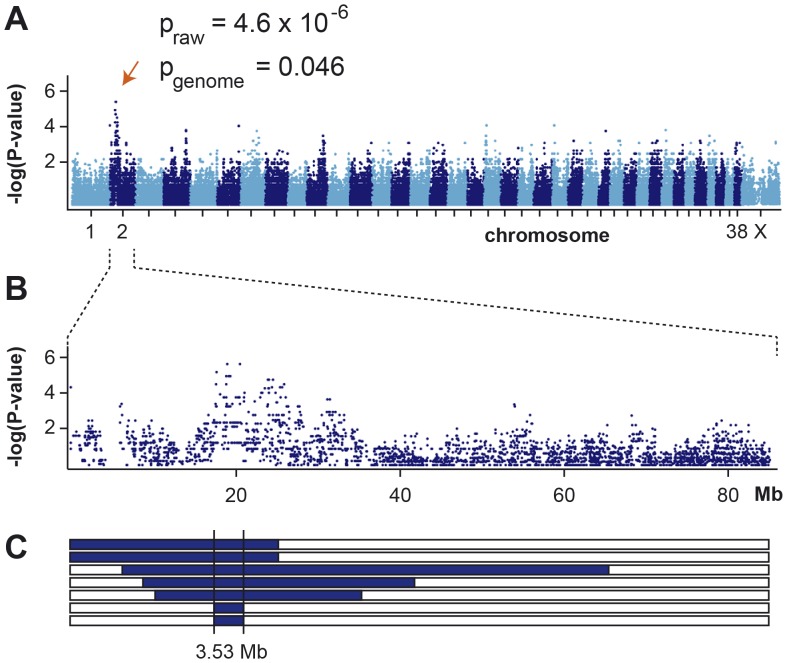
Mapping of IGS in Border Collies.(A) A genome-wide association study using 7 cases and 7 controls indicates a signal on CFA 2. (B) The detailed view of CFA 2 delineates an associated interval of ∼5 Mb. (C) Homozygosity mapping. Each horizontal bar corresponds to the CFA 2 genotypes of the 7 analyzed cases. Homozygous regions with shared alleles are shown in blue. A shared homozygous interval delineates the exact boundaries of the critical interval from 17,283,880 to 20,818,258 bp (CanFam 3 assembly).